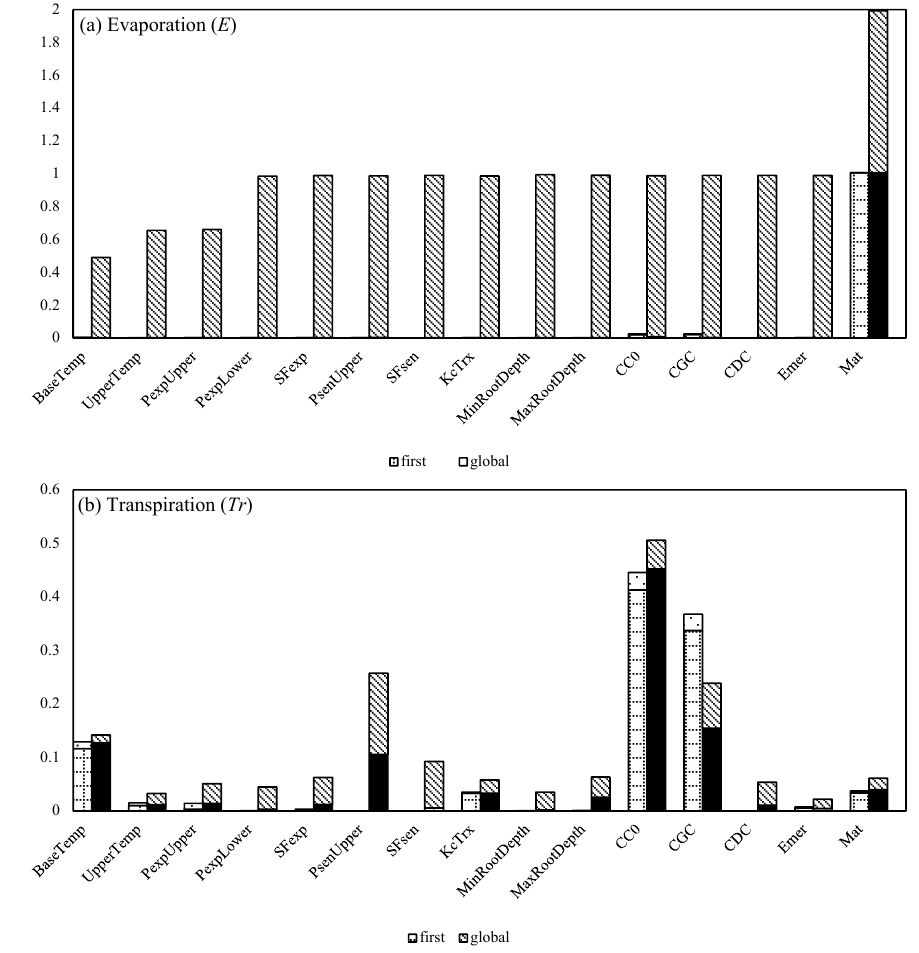
Figure 2. The Sobol’ global sensitivity analysis (GSA, M, ; N, ), and first order sensitivity analysis (SA, M, ; N, ) indices for the AquaCrop model output of evaporation ( E) and transpiration ( Tr) . Model input parameters were those sensitive by the Morris screening method.